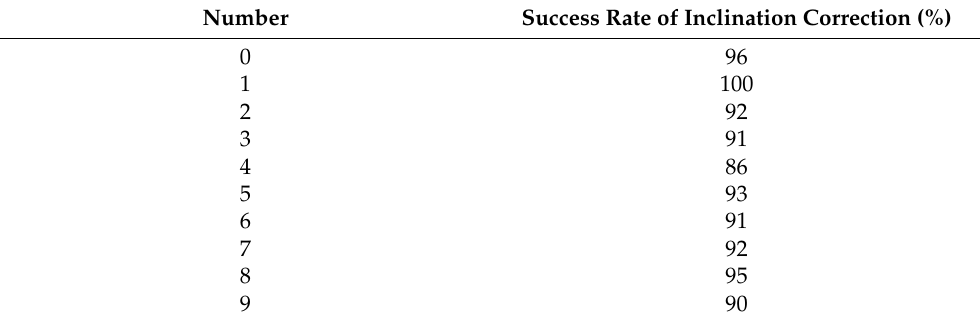
Table 1. Overall success rate.